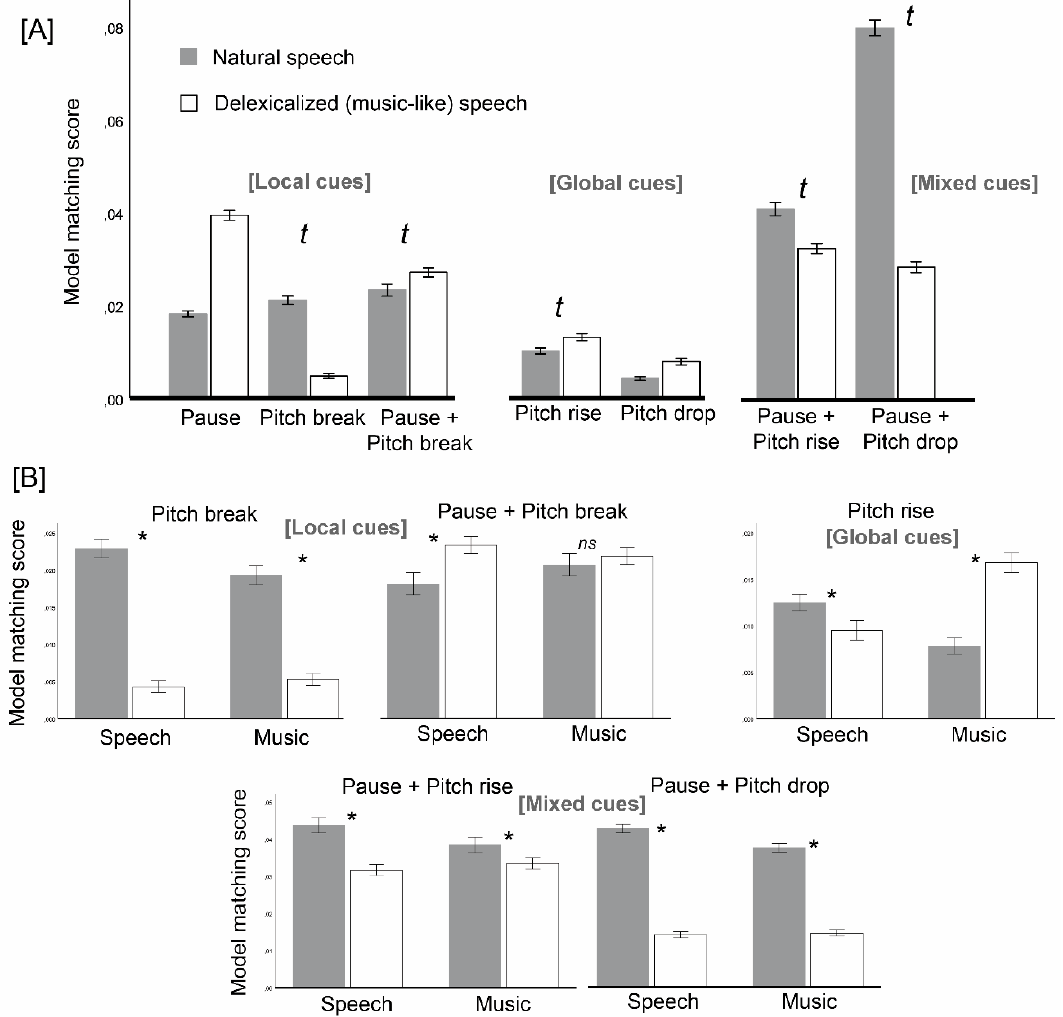
Figure 3. E ff ects of delexicalization (natural vs. delexicalized speech), model (7 models) and instruction (speech prosody vs. music) on model matching. A: Delexicalization e ff ects per model, with five out of seven models (Pitch break, Pause + Pitch break, Pitch rise, Pause + Pitch rise, Pause + Pitch drop) showing delexicalization x instruction interactions (marked with t ). B: Delexicalization x instruction interactions per model. Vertical bars represent the standard error of the mean.